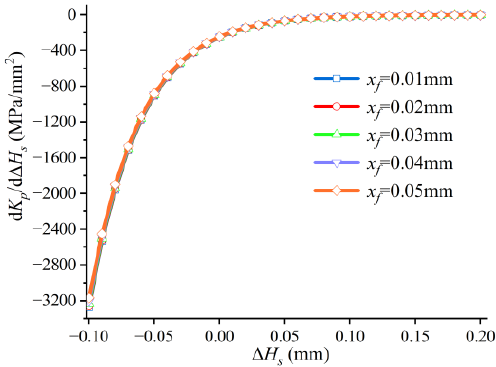
Figure 28. Pressure gain robustness against deflector installation error.